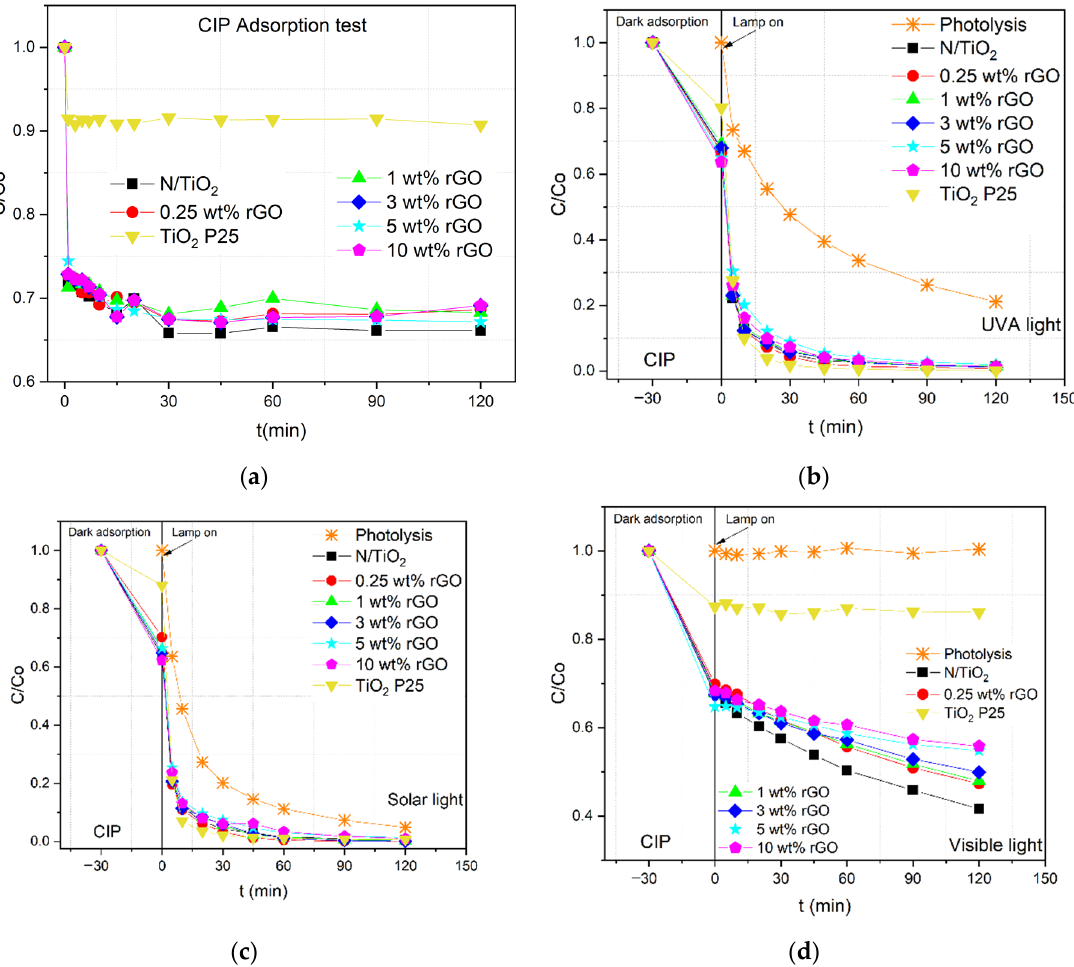
Figure 4. ( a ) Adsorption–desorption equilibrium and photocatalytic degradation of ciprofloxacin CIP by N/TiO 2 and N/TiO 2 /rGO with different amounts of rGO under ( b ) UVA light, ( c ) solar light simulator (SLS), and ( d ) cold visible light (CVL).